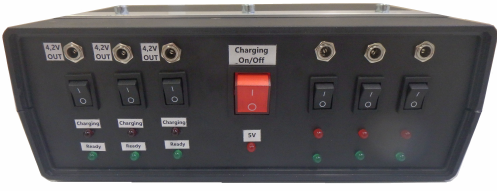
Figure 5. Power supply unit - front side.